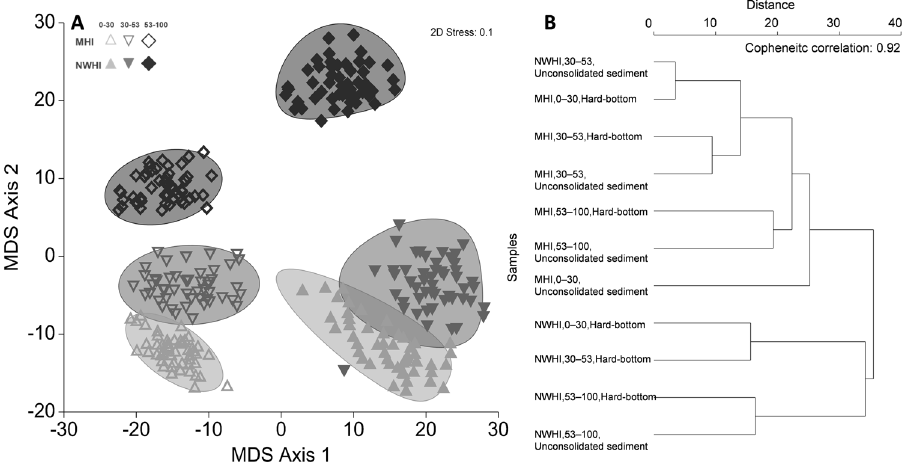
Figure 3. ( A ) Bootstrap resampling plot , 50 bootstraps per group. Square root transformed, zero-adjusted Bray Curtis roving predator abundance data ( MaxN , hr − 1 ) by Region (MHI, NWHI) x Depth Strata (SPC; upper and lower mesophotic), plotted metric multi-dimensional scaling (mMDS). Shaded bootstrap regions, which represent measurements of centroid error: 95% confidence ellipses, averages based on m = 10 dimensional metric MDS (rho = 0.985). Open symbols represent MHI sites, closed symbols represent NWHI sites. Light grey = shallow water (0–30 m), medium grey = upper mesophotic (30–53 m), dark grey = lower mesophotic (53–100 m). ( B ) Hierarchical cluster analysis dendrogram of group centroids f by Region (MHI, NWHI), Depth (0–30 m, 30–53 m, 53–100 m), and Habitat (Hard-bottom, unconsolidated sediment). Note the absence of NWHI unconsolidated sampling sites between 0–30 m. Cophenetic correlation =